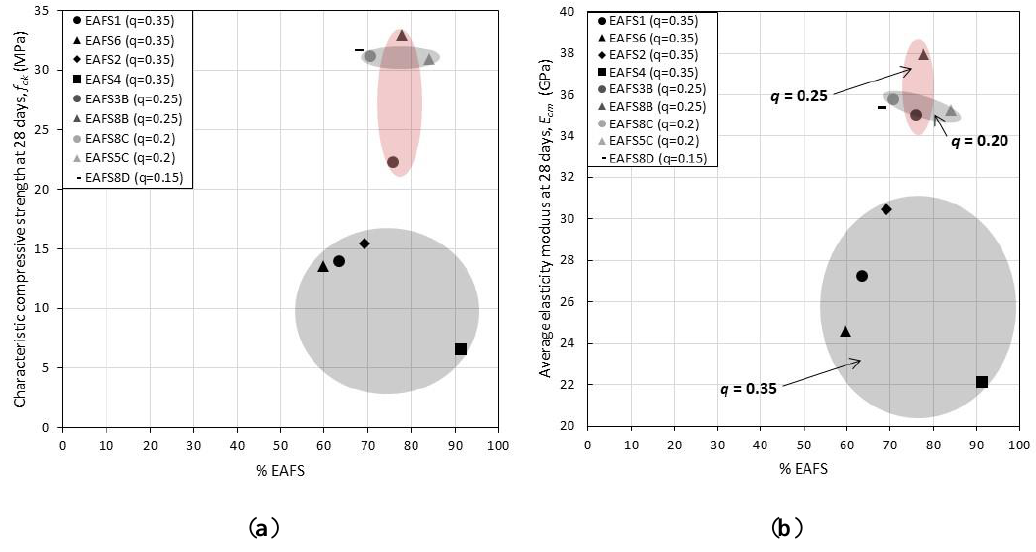
Figure 14. Mechanical behavior as function of the amount of EAFS aggregates at 28 days: ( a ) char- acteristic compressive strength, f ck ; ( b ) average elasticity modulus, E cm .